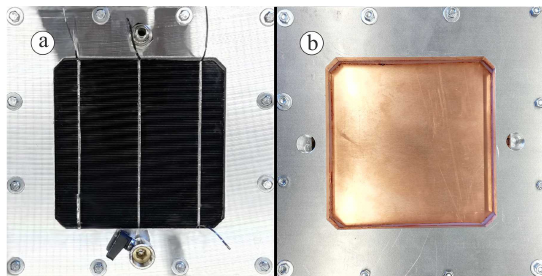
Fig. 2. View of the test module: a) side of the solar panel, b) side of a copper